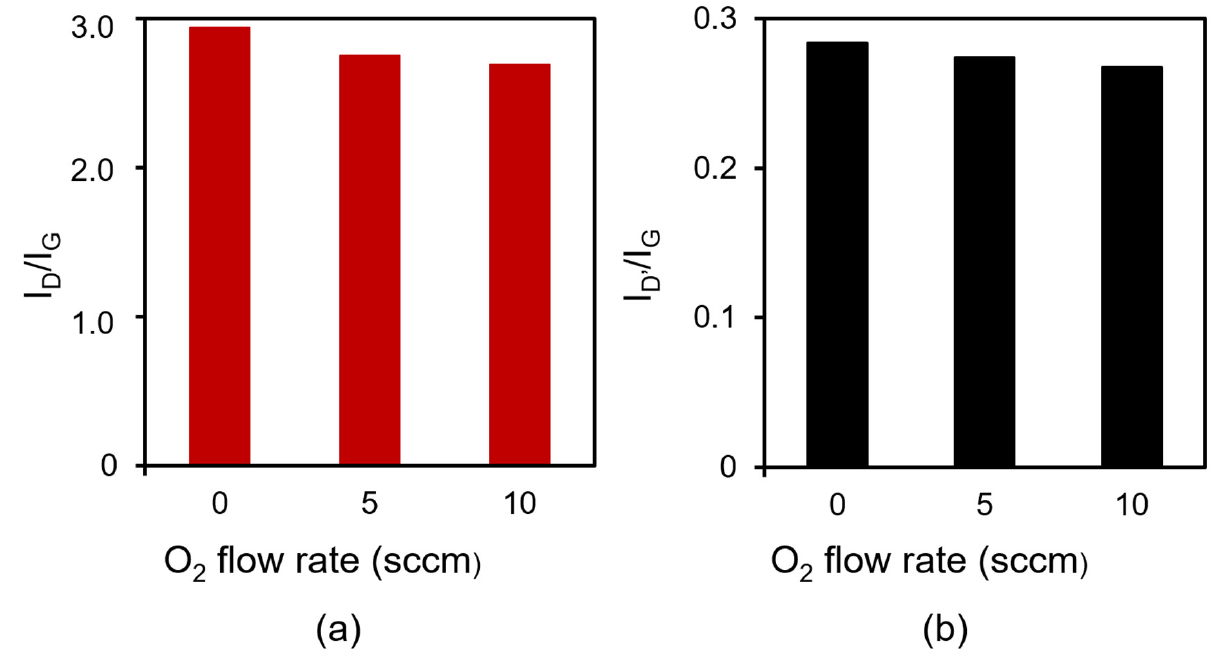
Figure 4. Peak area intensity ratios for ( a ) the D-band to G-band peaks (I D /I G ) and ( b ) those for the D’-band to G-band peaks (I D’ /I G ) in Raman spectra for normal CNWs, 5-sccm-O 2 –, and 10-sccm-O 2 – high-quality CNWs.